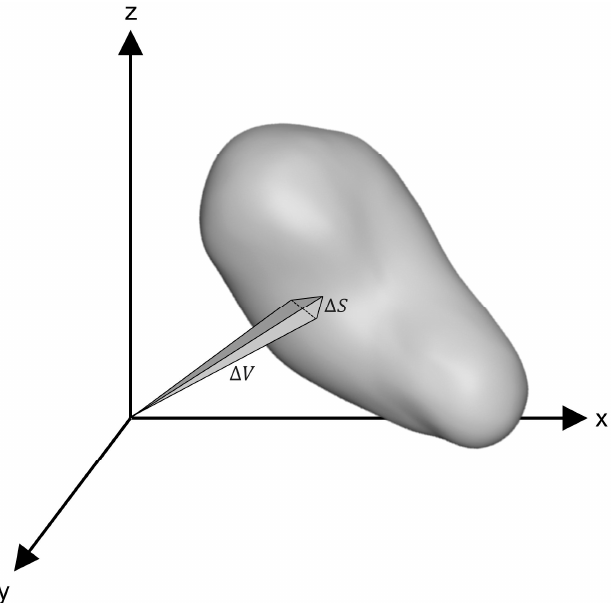
Figure 7. A mesh facet expanded into a signed tetrahedron with its apex at the origin. Adapted from Lien and Kajiya [77].